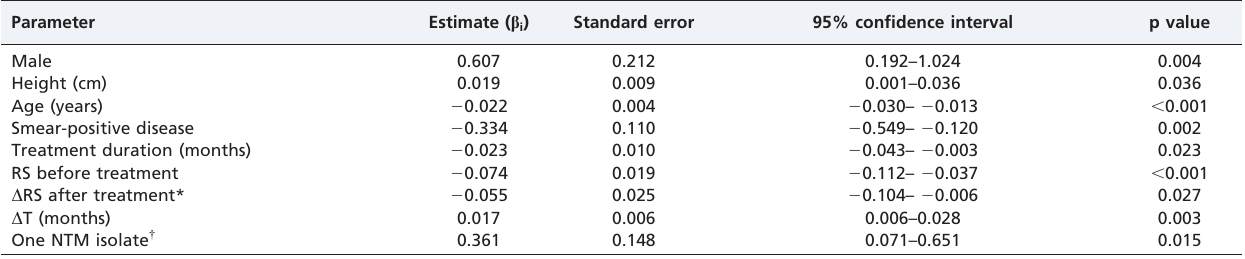
Table 2 - Predictors of FEV 1 within 60 months after completion of treatment for pulmonary tuberculosis. Parameter